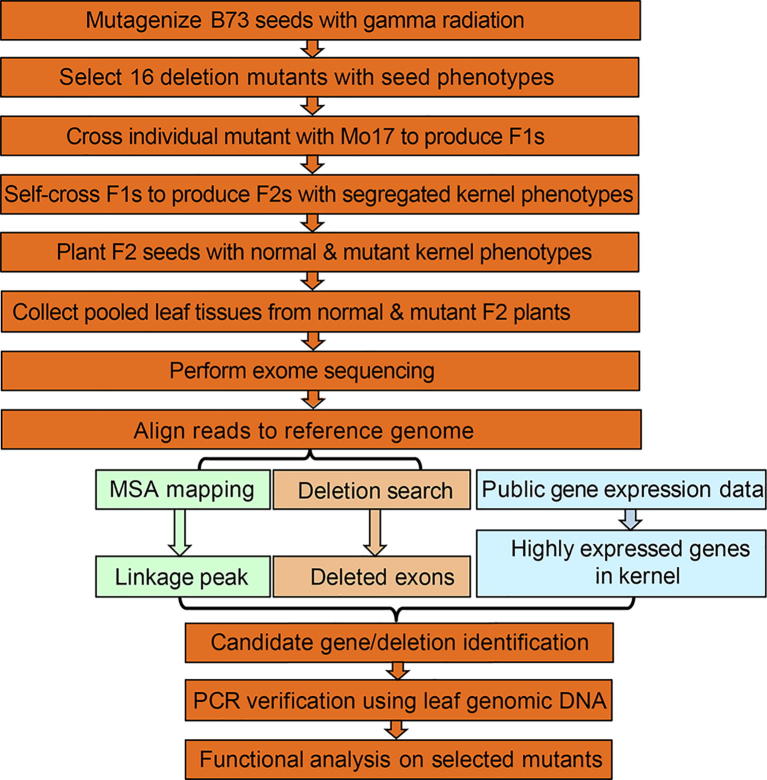
BSEx-seq work flow